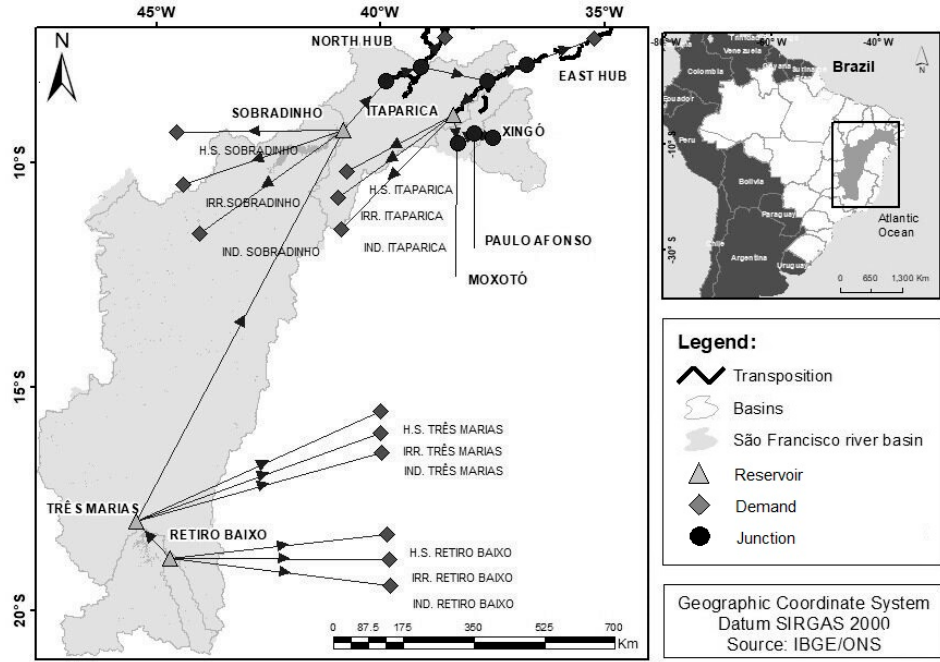
Figure 6. São Francisco River hydrosystem flow network model. Figure 6. S ã o Francisco River hydrosystem flow network